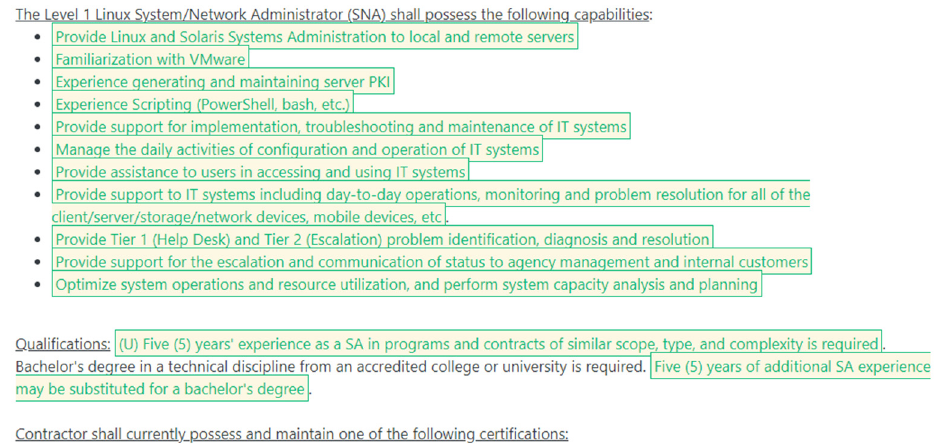
Figure 22. A job advertisement for a position Linux Systems Network Administrator with Polygraph with 0% match with the Open Skills database.